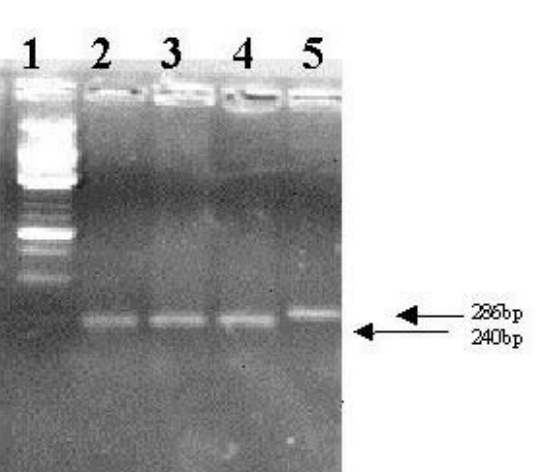
Figure 1 - Agarose gel electrophoresis of RFLP Hinc II digested PCR am- plified DNA. Lane 1 = 250 bp molecular weight marker; Lanes 2, 3 and 4 = 240 bp digested fragment from wild-type homozygotes (CCR5/ CCR5); Lane 5 = 286 bp non-digested fragment (negative